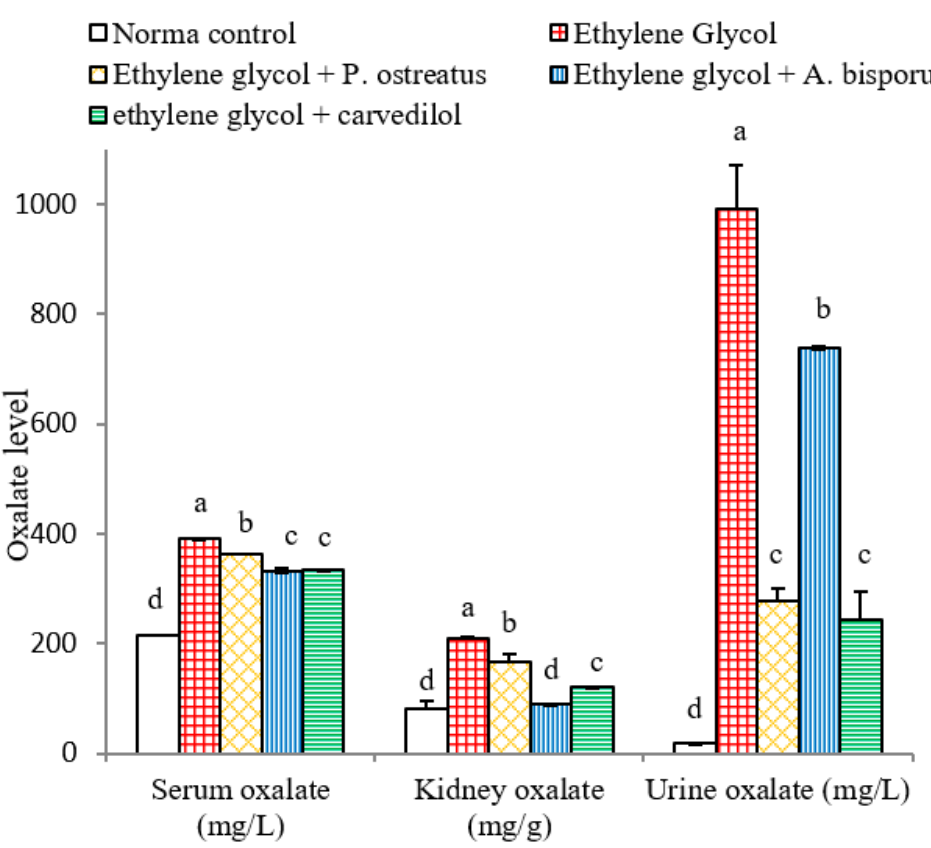
Figure 8. Effect of P. ostreatus and A. bisporus aqueous extracts and carvedilol on serum, kidney and urine oxalate levels in ethylene glycol-administered rats. For each parameter, means which share the same letter(s) are not significantly different.